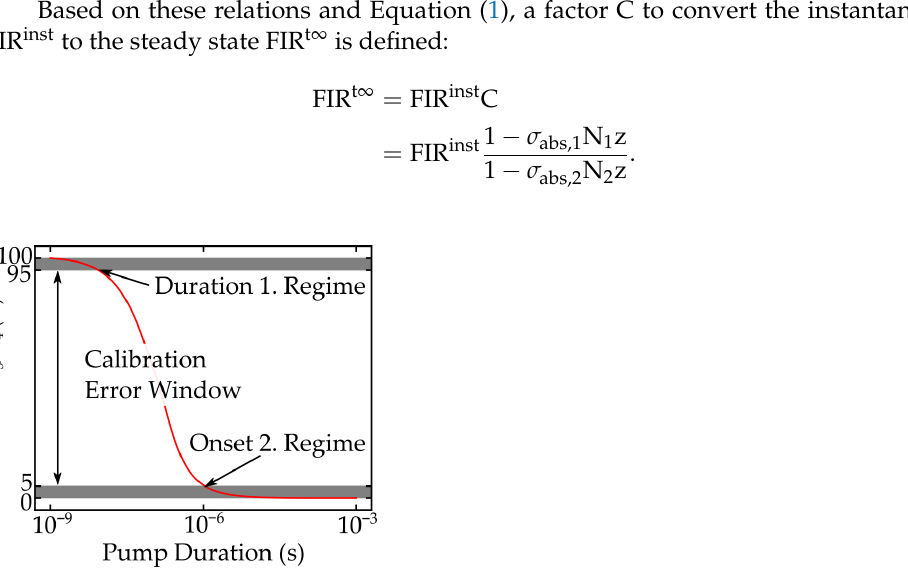
Figure 3. Exemplary depiction of the different calibration regimes caused by changes in energy level